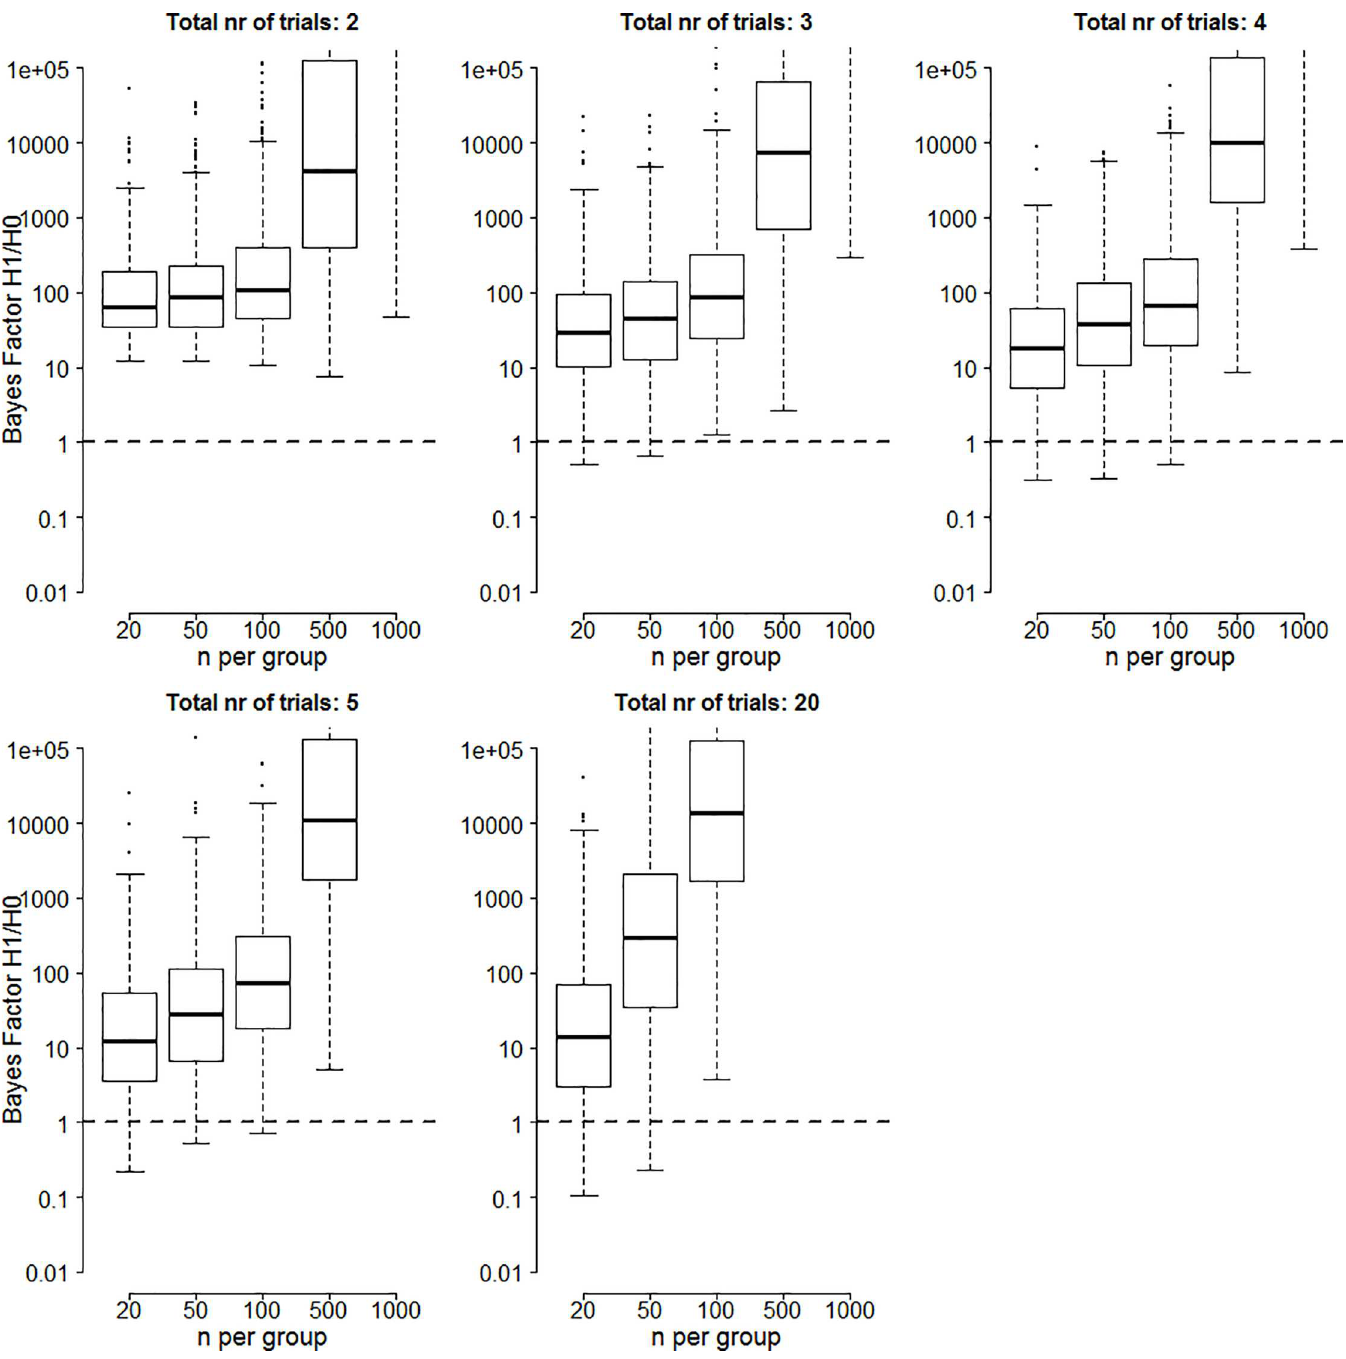
Fig 1. Bayesfactors in favor of the alternative hypothesis for two significant trials when the true effect size is 0.2. Boxes contain Bayes factors for 50% of the simulations with tails extendingto Bayes factors for 100% of the simulations excludingoutliers. Circles indicateoutliers and are those values more than 1.5 * IQRremoved from the boxes. Note that for large numbersof participants, Bayes factors increase exponentially and only the tail of the boxes is